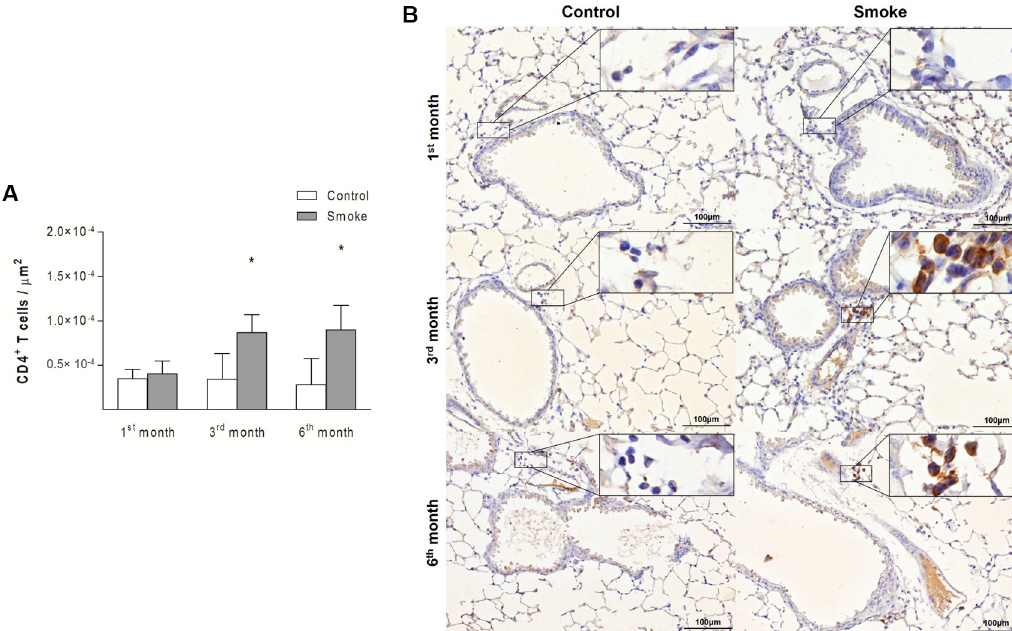
Fig 4. CD4 + T cells in peribronchovascular areas. The numbers of CD4 + T cells in peribronchovascular areas obtained for the Control groups after 1 (n = 10), 3 (n = 6), and 6 (n = 7) months and the Smoke groups after 1 (n = 9), 3 (n = 5), and 6 (n = 7) months are presented as the means ± SDs. (A) Significant differences were found after 3 ( � P = 0.0190, Mann-Whitney test) and 6 ( � P = 0.0023, Mann-Whitney test) months. (B) Representative photomicrographs of CD4 + T cells in peribronchovascular areas are shown at 200 × magnification, and images at 1000 × magnification are shown in each insert.